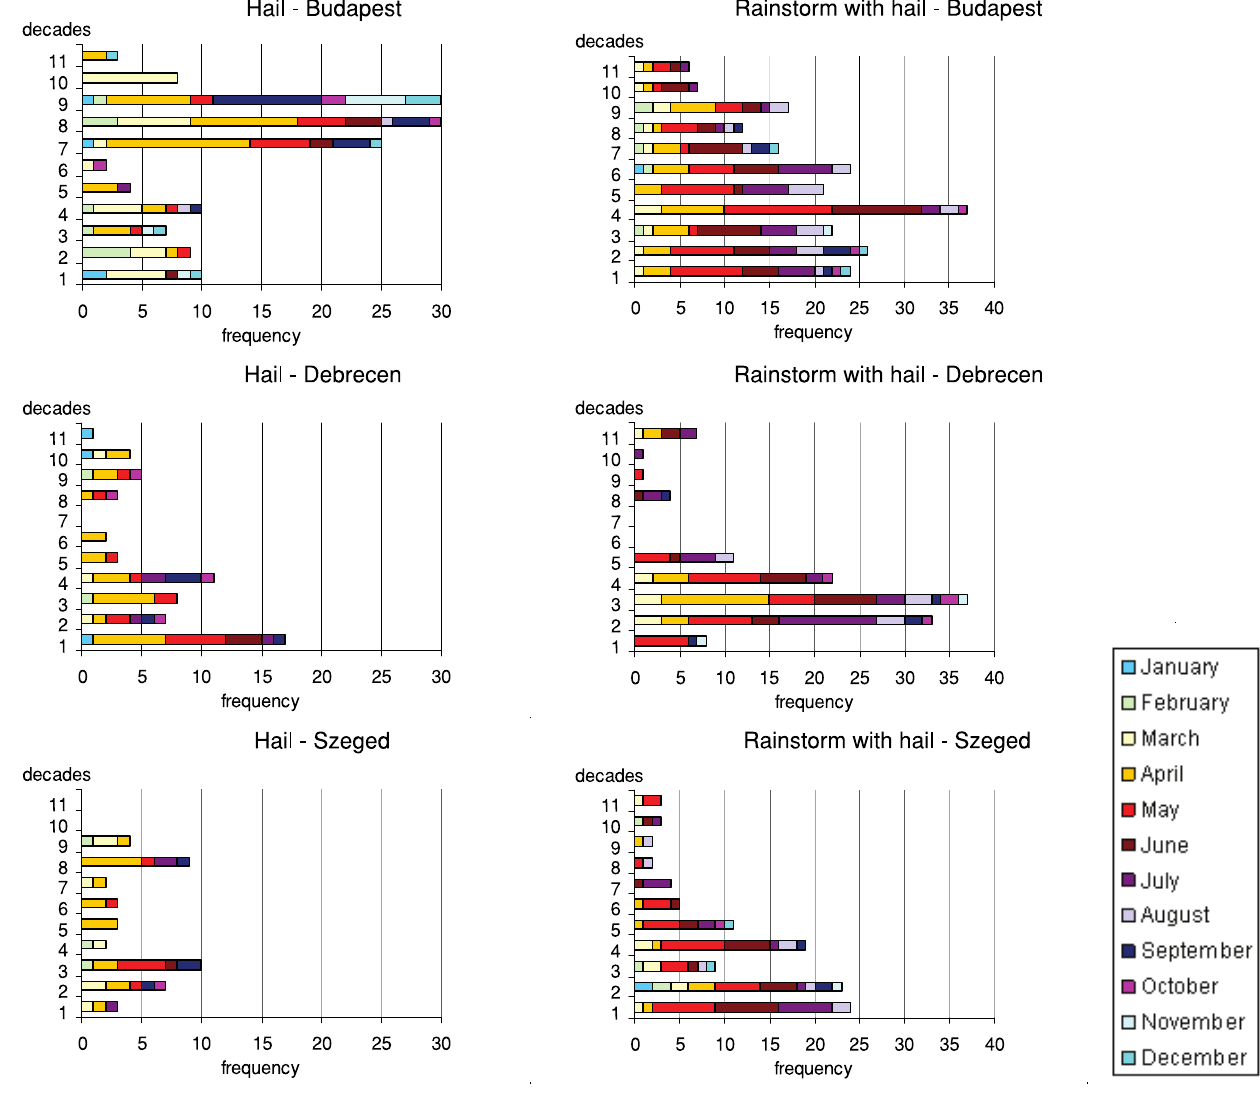
Figure 5: The frequencies of hail events, 1901–2008 (the last – truncated – decade contains 8 years, only) Table 2. The typical month of hail occurrence (* indicates uncertain characteristics) Budapest Budapest Debrecen Decade